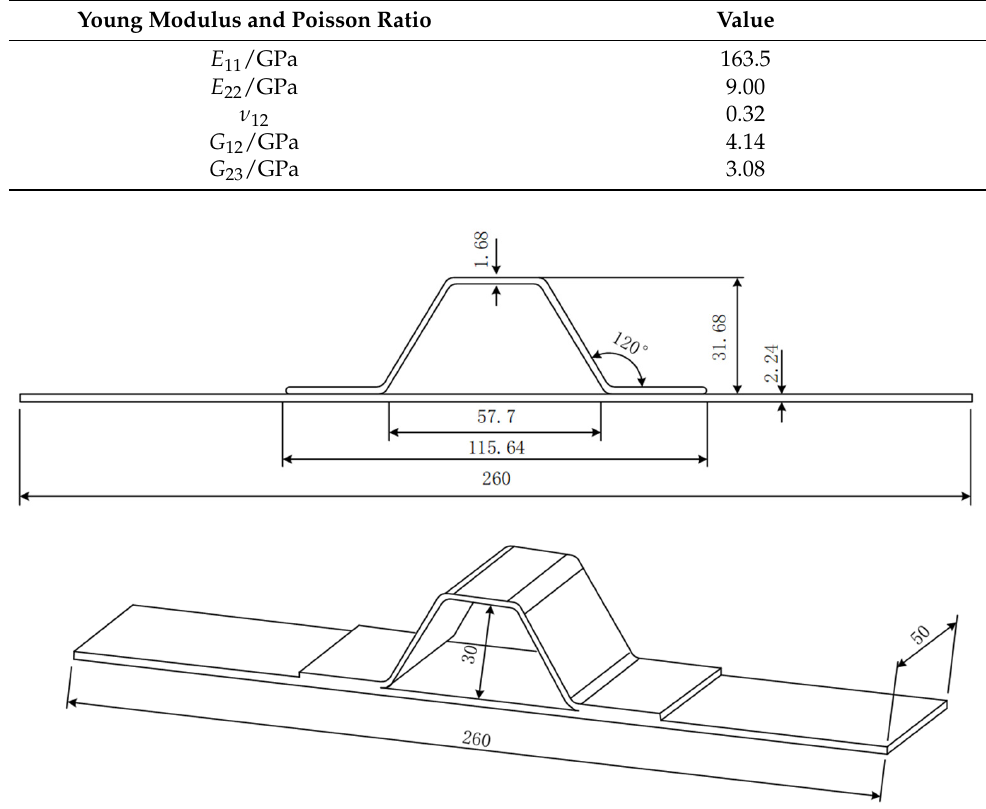
Figure 4. The configuration and geometry of specimen. (Unit: mm). Table 2. Layer information of the specimen .